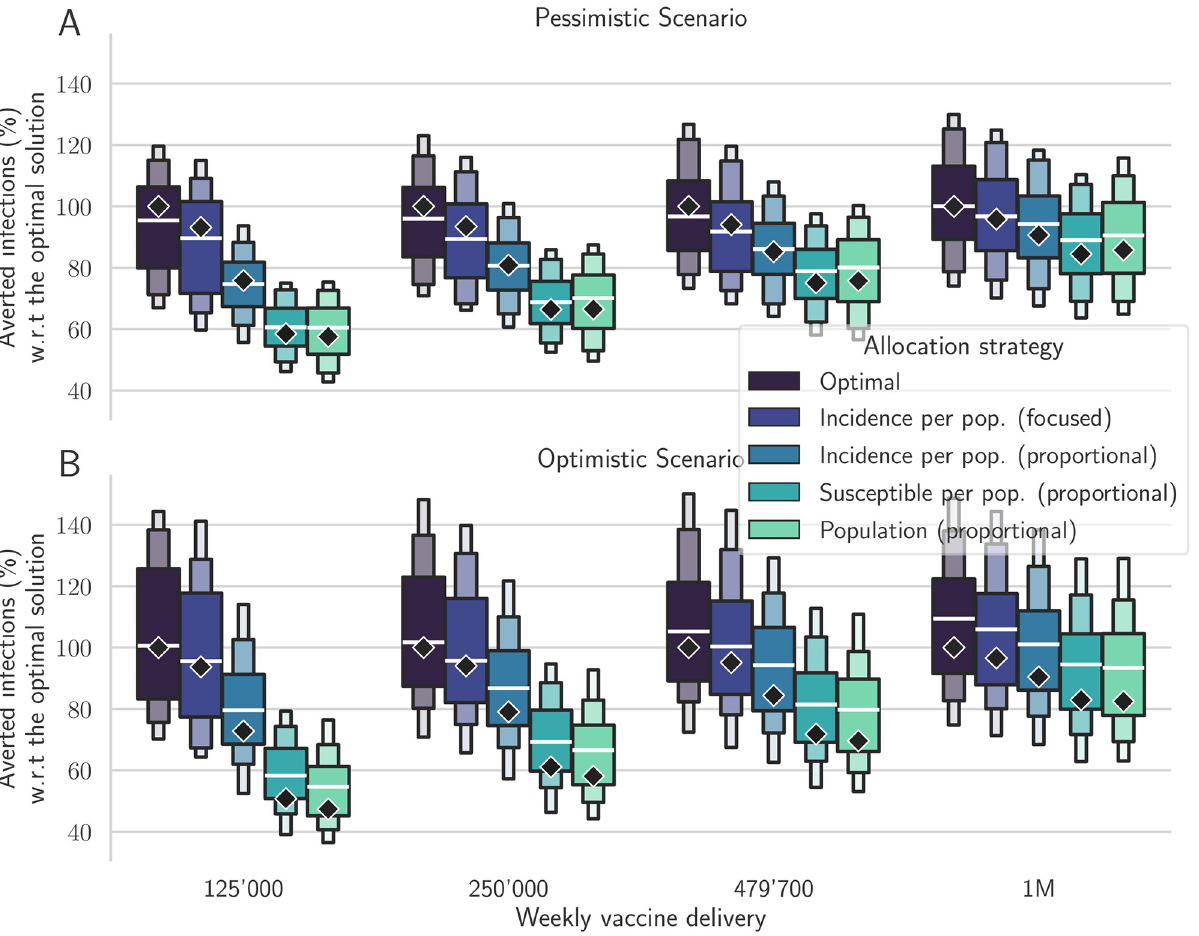
Fig 3. Comparison between different vaccine allocation strategies. Percentage of averted infections per vaccine dose from January 4, 2021, to April 4, 2021, resulting from province-scale vaccine allocation strategies for both the pessimistic (A) and the optimistic (B) scenarios based on the following vaccination strategies: the optimal solution, proportional to the province population, proportional to the susceptible individuals, proportional to the projected incidence, and focused on the provinces with the largest weekly incidence (see color codes in the legend). We optimize the vaccine allocation for the reference trajectory (the median trajectory in the model projections, indicated as diamonds in the figure), and assess the performance of the computed vaccination strategy over the whole posterior of trajectories (boxen plots). For each projection scenario, the results are normalized by the number of averted infections in the reference solution (see Table 1 for the absolute values). Results for alternative scenarios and vaccination strategies are shown in Fig I in S1